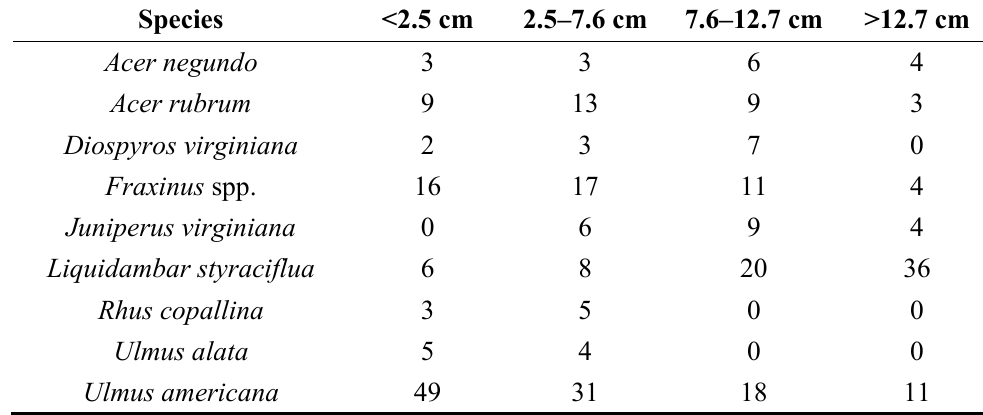
Table 2. Alphabetized list of the ten most common native, volunteer tree species present (excluding Quercus species & Elaeagnus umbellata ) and abundance (percent) within each of the four DBH